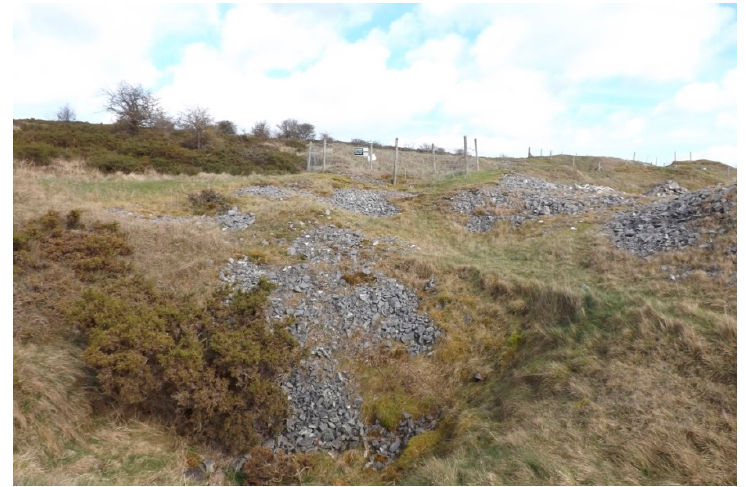
Figure 2. Old lead mine shafts and workings, Halkyn Mountain. Photo © Mark Nuttall.